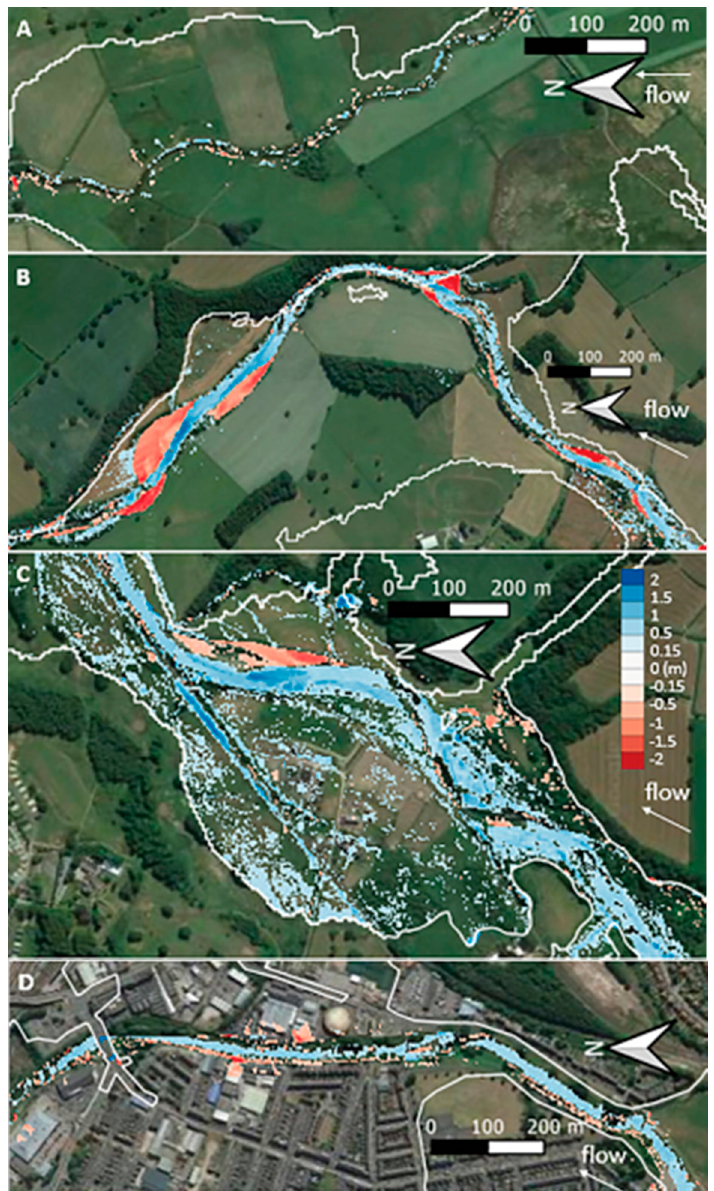
Figure 5. Bank erosion and in-channel sediment accumulation styles within the four reaches of the River Caldew study area measured between 2005 and 2016. The white boundary is the floodplain limit (Environment Agency flood zone 3 representing the 1:100 year return period flow on the annual maximum series) (background imagery © Maxar Technologies / Google). Change in the upper Reach A above Hesketh Bridge is associated with transient gravel and cobble deposits moving over a largely fixed armoured channel bed ( A ) compared to widespread sediment accumulation in Reaches B, C and D below Hesketh Bridge. In Reach B in-channel accumulation occurs as point bar and ri ffl e units ( B ) and in Reach C as large bar complexes where deposition of mid-channel and lateral bars is associated with channel widening ( C ), whilst in Reach D accumulation is through more general bed aggradation forming a plane bed channel ( D